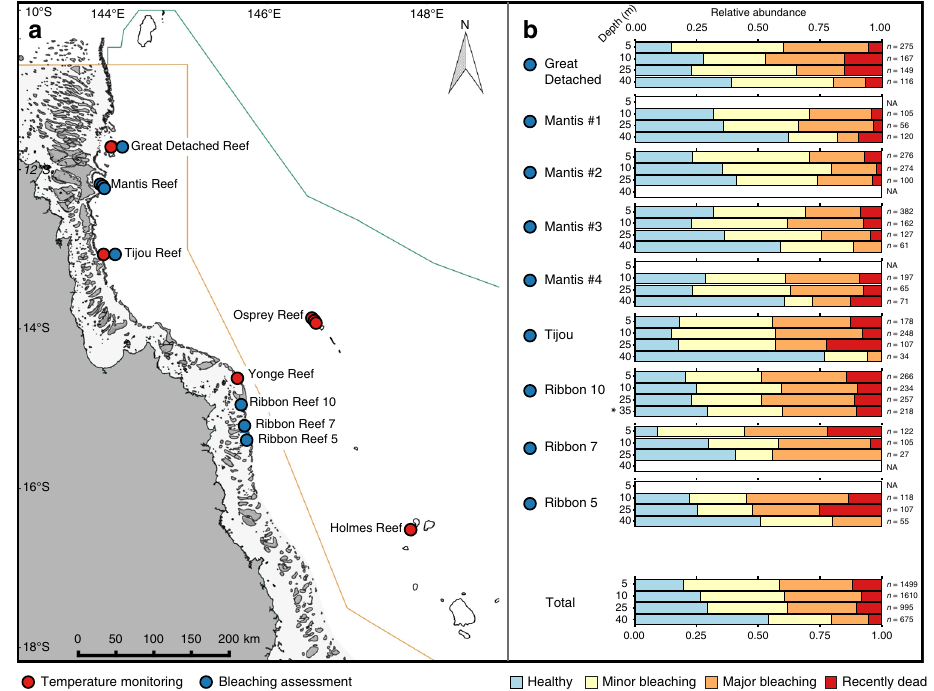
Fig. 1 Overview of surveyed locations and respective bleaching impacts over depth. a Reef locations for which long-term temperature recordings (red dots) and/or bleaching surveys (blue dots) were obtained on the Great Barrier Reef (GBR) and in the Western Coral Sea (WCS). b Community-wide bleaching severity over depth (5, 10, 25 and 40 m depth) during the 2016 mass bleaching event. Stacked bar graphs give the relative abundance of bleaching categories for each depth and location. Number of observations noted next to each stacked bar, with NA denoting depths that lacked a coral reef community. Asterisk (*) indicates site where data was collected at 35 m depth due to absence of reef formation at 40 m. Bleaching surveys were performed on 14 – 23 May 2016, ∼ 10 weeks after the fi rst reports of minor to moderate coral bleaching in three management areas of the GBR Marine Park 17 . Map created with data fi les courtesy of Great Barrier Reef Marine Park Authority and www.deepreef.org under CC BY